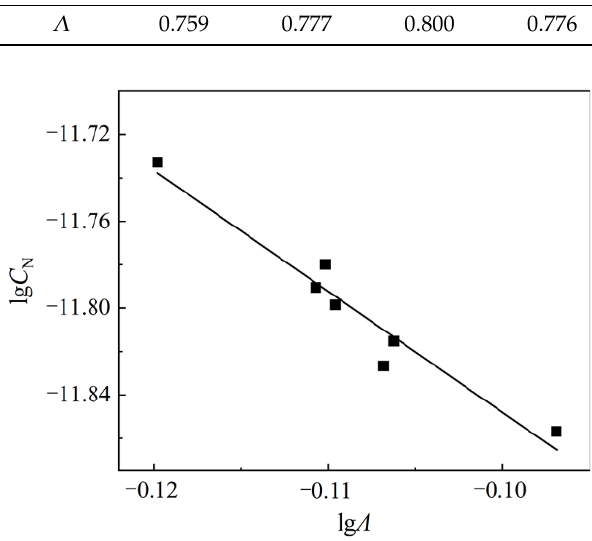
Figure 7. Optical basicity and nitrogen capacity.